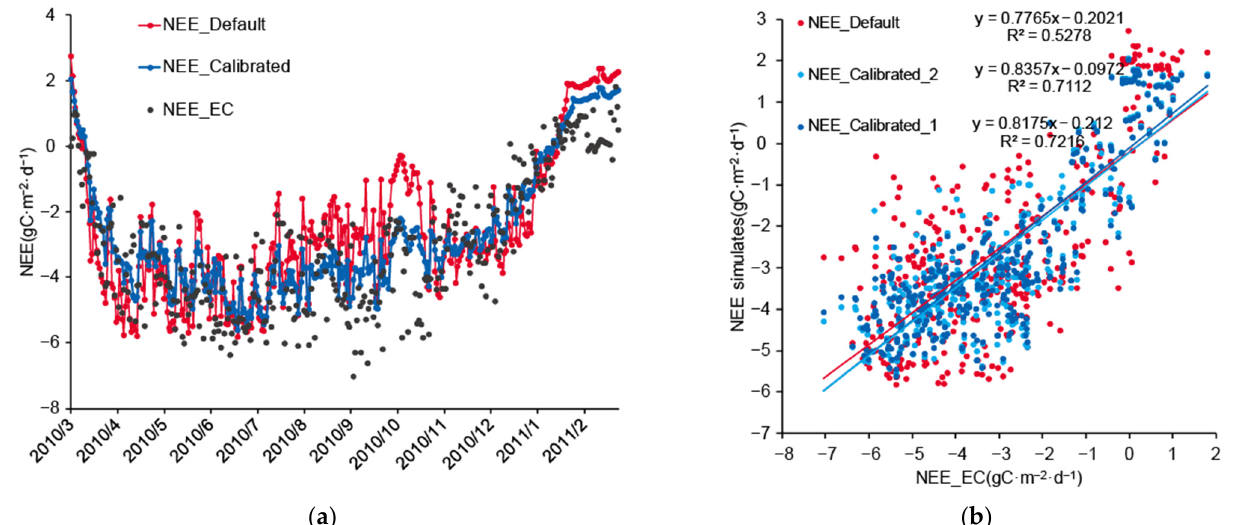
Figure 3. ( a ) Comparisons of NEE values simulated from the default and calibrated Biome-BGC model in 2010. ( b ) Scatterplot of the actual NEE values and the NEE values simulated from calibration with Scheme 1 and Scheme 2.